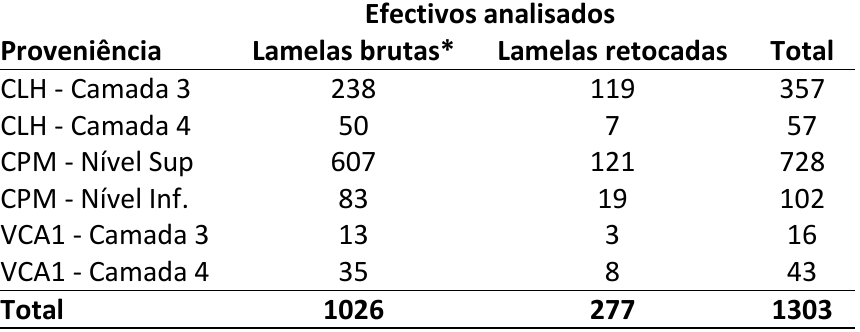
Tabela 3. Número de lamelas analisadas e subdivisão por peças sem retoque (brutas) e retocadas. VCA1 - Abrigo 1 de Vale Covões; CLH - Lapa dos Coelhos; CPM I - Cabeço de Porto Marinho I. * - Incluindo lamelas de buril Table 3. Number of analyzed bladelets (unretouched and retouched). VCA1 - Abrigo 1 de Vale Covões; CLH - Lapa dos Coelhos; CPM I - Cabeço de Porto Marinho I.*- Including burin spalls.